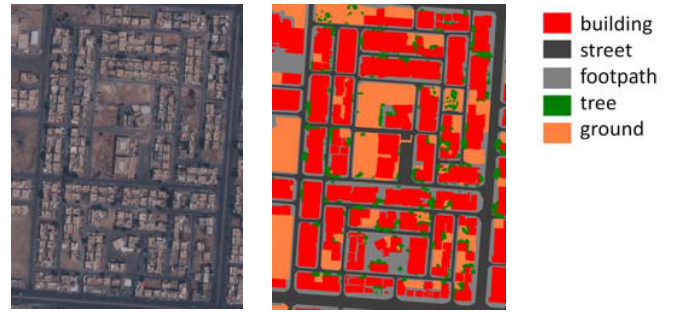
Figure 3: Orthophoto (left) and manually created reference label image (right); classes see legend